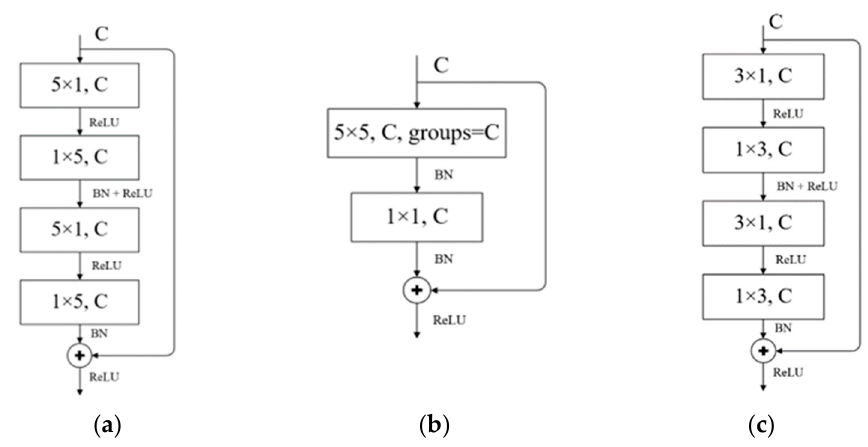
Figure 7. ( a ) Non-Bt-1D-5 module, ( b ) DSConv-5 module, and ( c ) Non-Bt-1D-3 module.